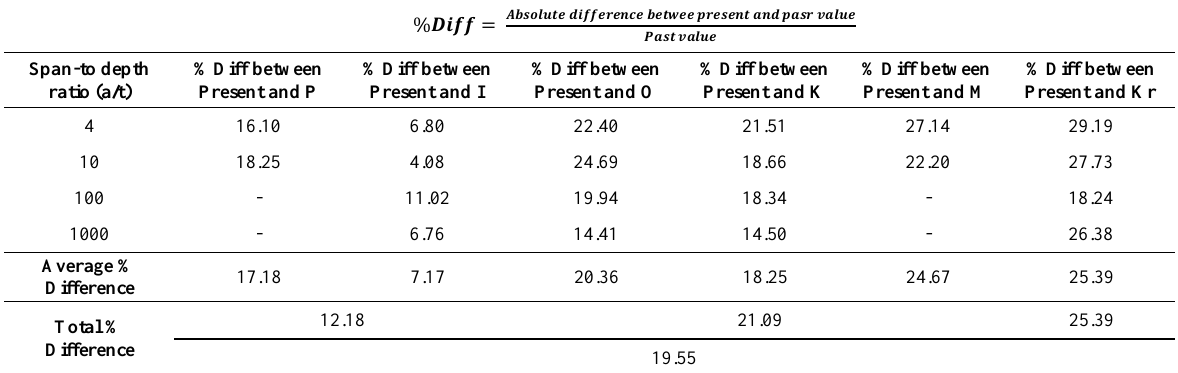
Span-to depth ratio